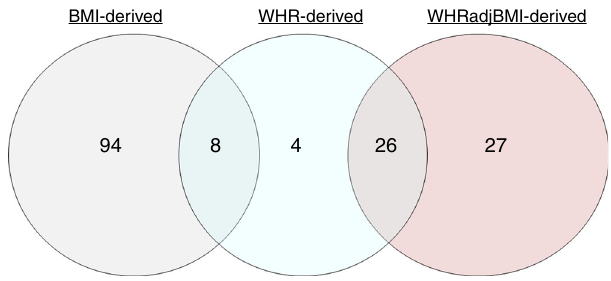
Fig. 1 Identi fi cation of 159 signals from three genomic scans. The Venn diagram shows the number of independent genome-wide signi fi cant ( P < 5 × 10 − 8 ) signals derived from the BMI − , the WHR − , or the WHRadjBMI- scan, respectively, and their overlap. We found no overlap between BMI- and WHRadjBMI-derived